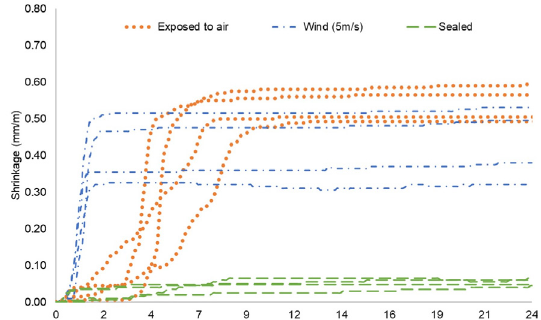
Figure 14. Early shrinkage curves of the individual specimens from the 1:3 mixture and the variation of different exposures to air.